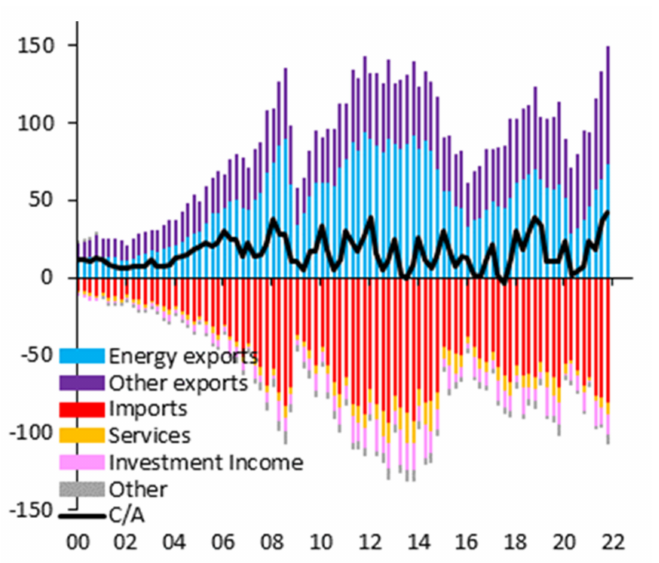
Figure 5. Composition of the Russian balance of payments (in USD billion)